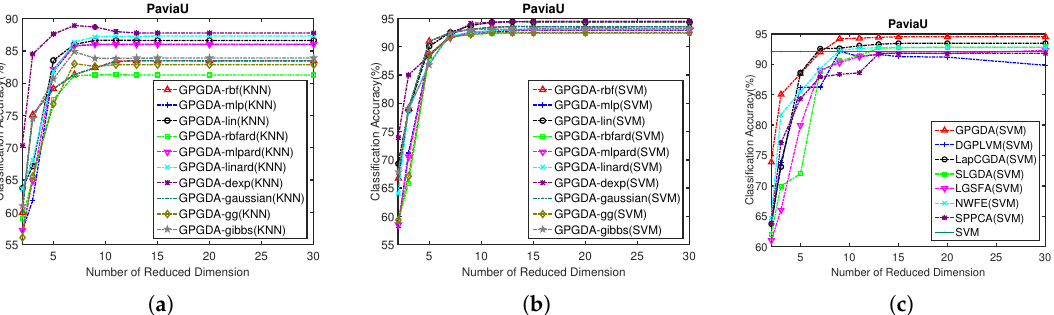
Figure 7. Classification accuracy w.r.t. different kernels and different dimensionality of the projection space on University of Pavia data: ( a ) KNN classification results of GPGDA based on different kernels; ( b ) SVM classification results of GPGDA based on different kernels; and ( c ) SVM classification results of all the DR methods based on different